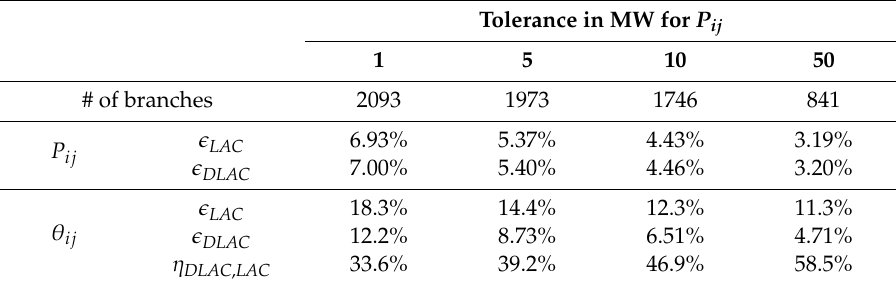
Table 7. Results of Active Power with DLAC and LAC for Hour 1 Case.